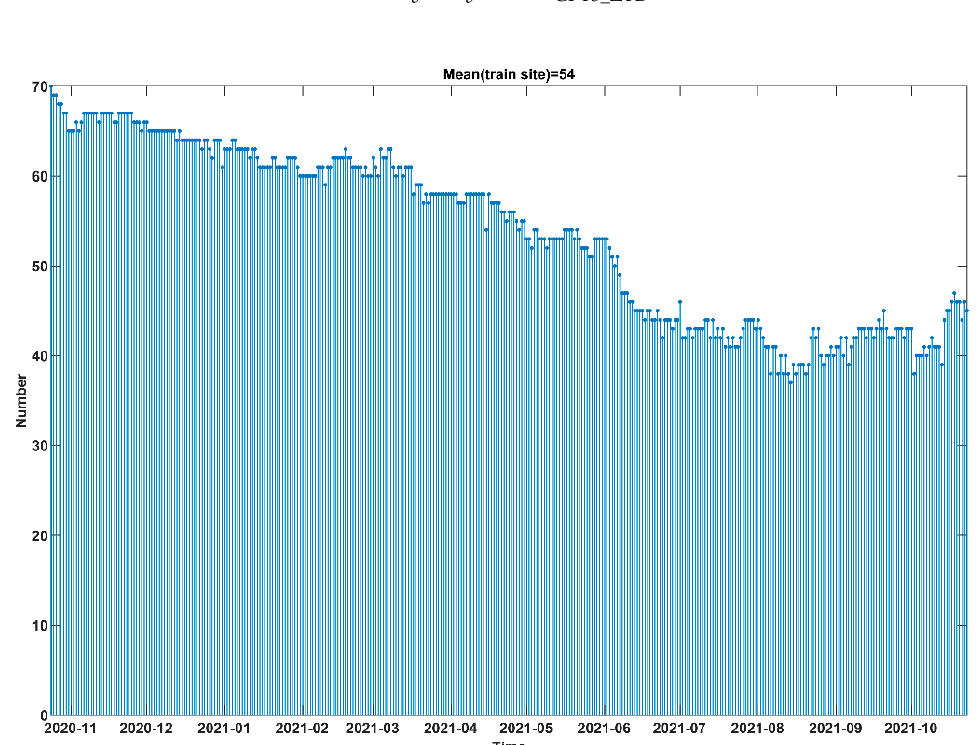
Figure 9. Statistical result of train samples and test samples of LSTM model.